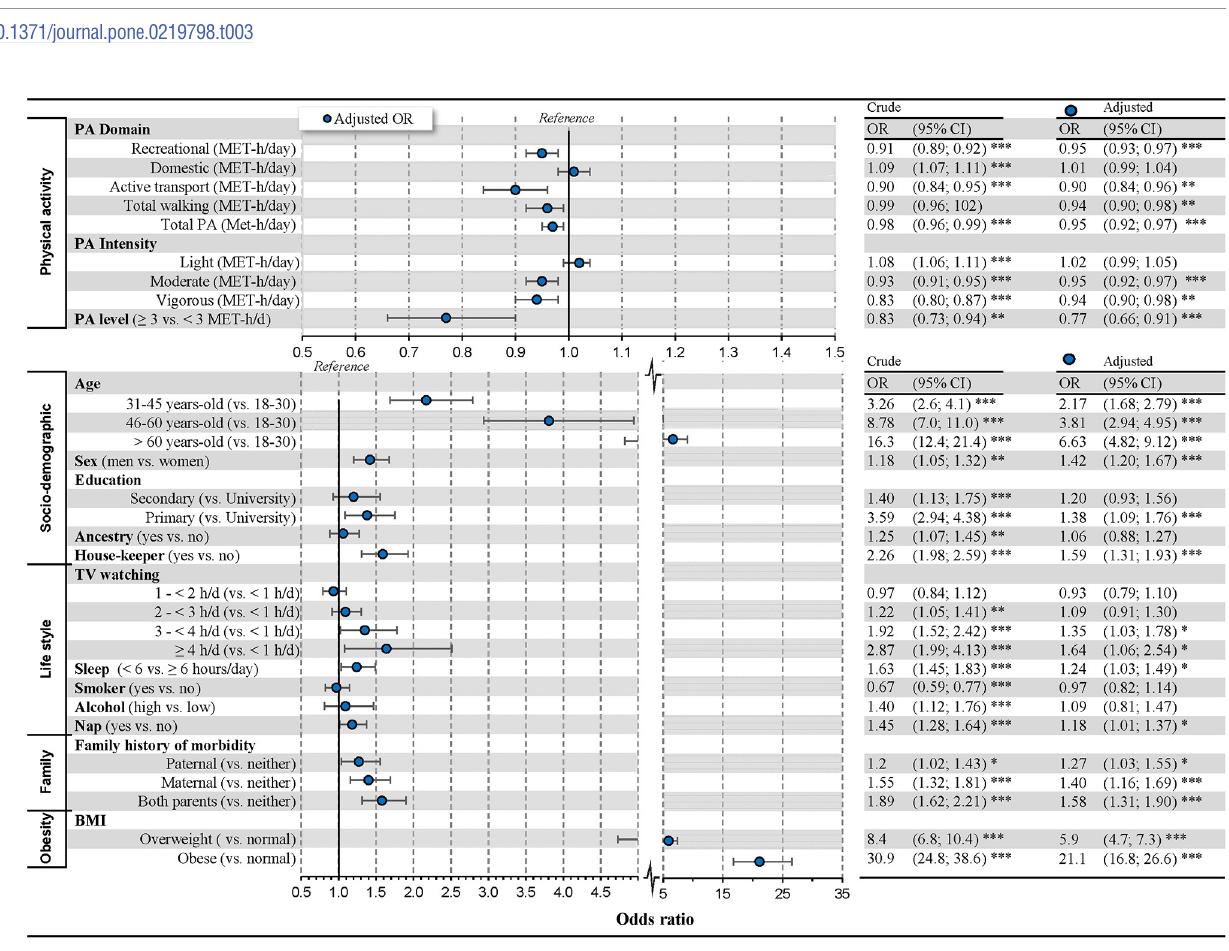
Fig 1. Associations of physical activity, socio-demographic, lifestyle, family history and obesity with metabolic syndrome. Note: OR = Odds ratio for having metabolic syndrome; 95% CI = 95% confidence interval for odds-ratio; � p < 0.05, �� p < 0.01, ��� p < 0.001. The OR for physical activity expresses the change for each increment of 1 MET-h per